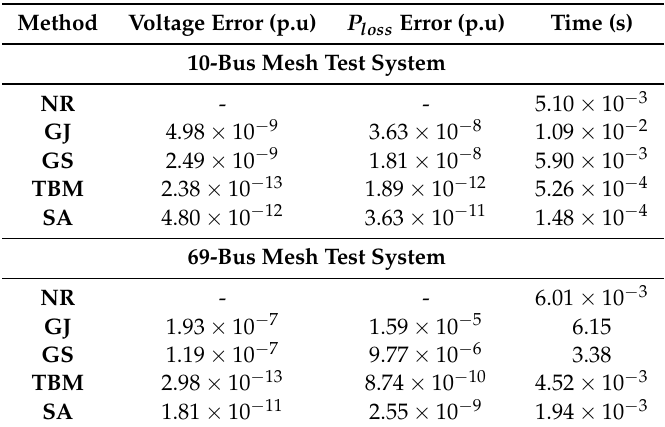
Table 3. Results obtained for test systems with mesh topology.